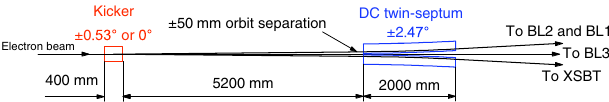
FIG. 3. Configuration of the beam line switchyard composed of kicker and dc twin-septum magnets located at the end of the linear accelerator.